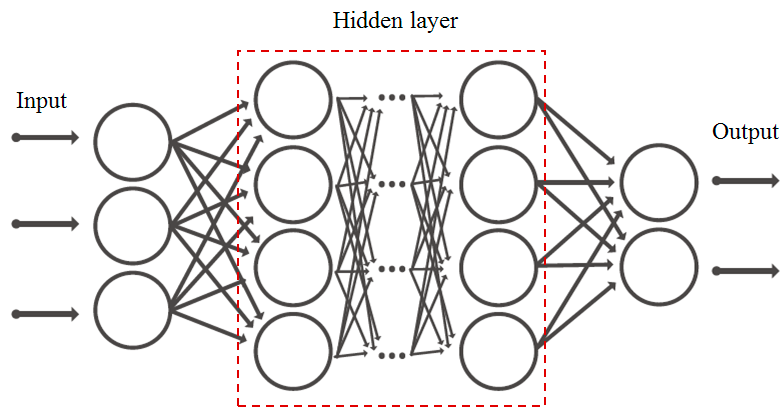
Figure 6. Schematic of neural network.